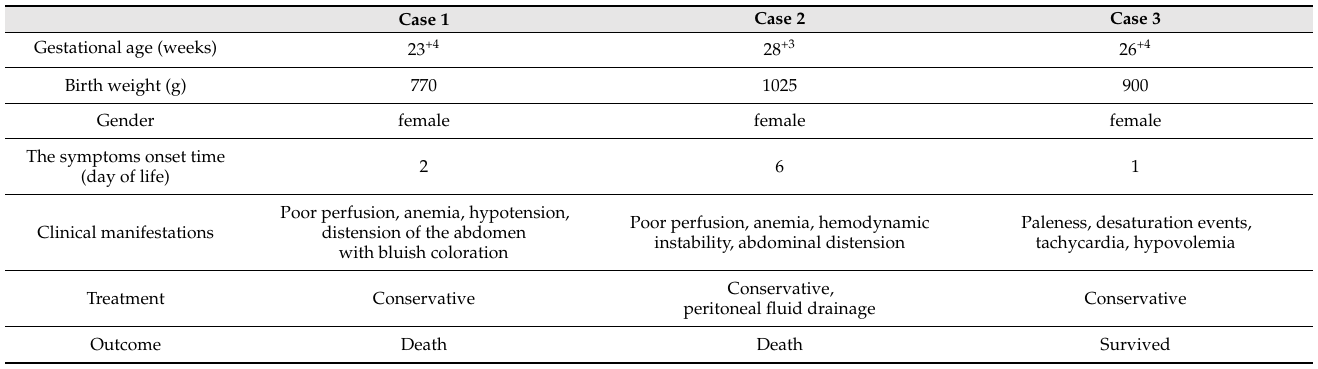
Table 1. The sequence of hematologic and coagulation tests performed prior and at the onset of clinical